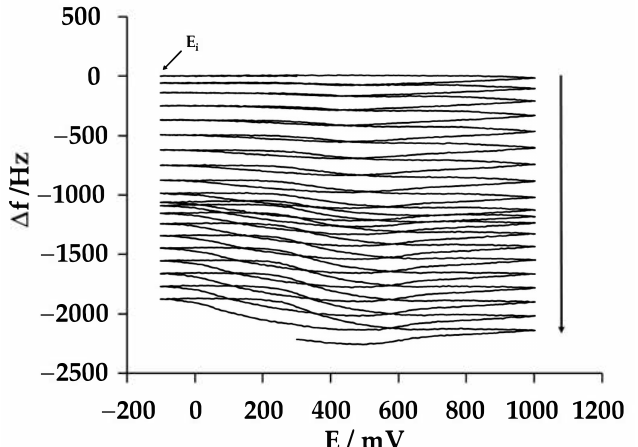
Figure 2. Curve of the frequency shifts ( ∆ f) as a function of the potential (E) obtained during the electrodeposition of pure PAni onto the gold electrode in the work solution at 50 mV s − 1